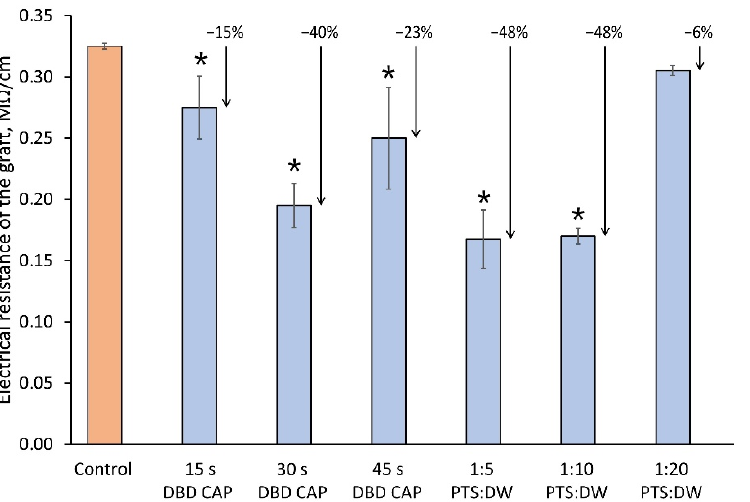
Figure 8. Resistivity of the graft (less is better) that corresponds to vascular system differentiation in the rootstock–scion interface. The measurement approach is described in Section 4.5. Number of samples was 5, and number of measurement repetitions was 5. * indicates a significant difference at 5% level in comparison with the control ( p < 0.05, ANOVA). Data are presented as mean values and standard errors of the mean.